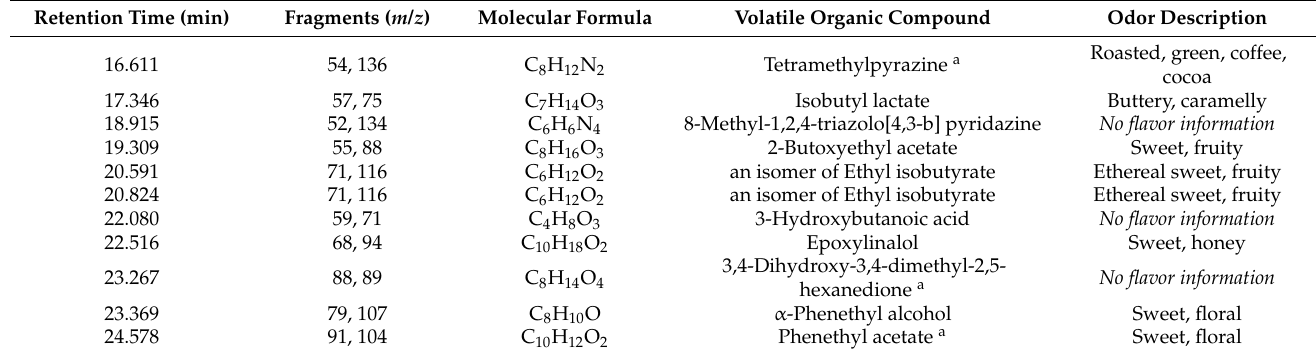
Table 2. Key-VOCs of northern Peruvian chocolate.